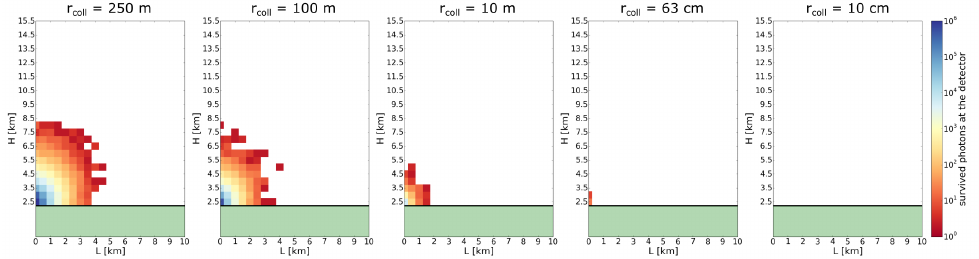
Figure 4. Detectability regions obtained from the Geant4 simulations. In the panels, the color of each ( L , H ) pixel represents the number of gamma-ray photons reaching a collecting area of radius r coll , survived from a TGF with N 0 = 10 10 initial gamma-ray seeds emitted in that ( L , H ) position. The black line with the green region indicates the separation with the ground surface on Mt. Cimone, at about 2165 m